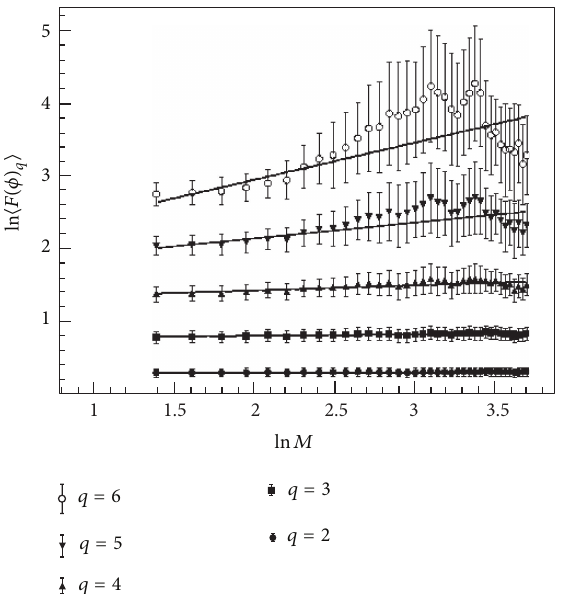
Figure 16: Intermittent behaviour of charged hadrons produced in 𝜙 -space in 28 Si-Ag/Br interactions at 14.6 AGeV. The figure is taken from